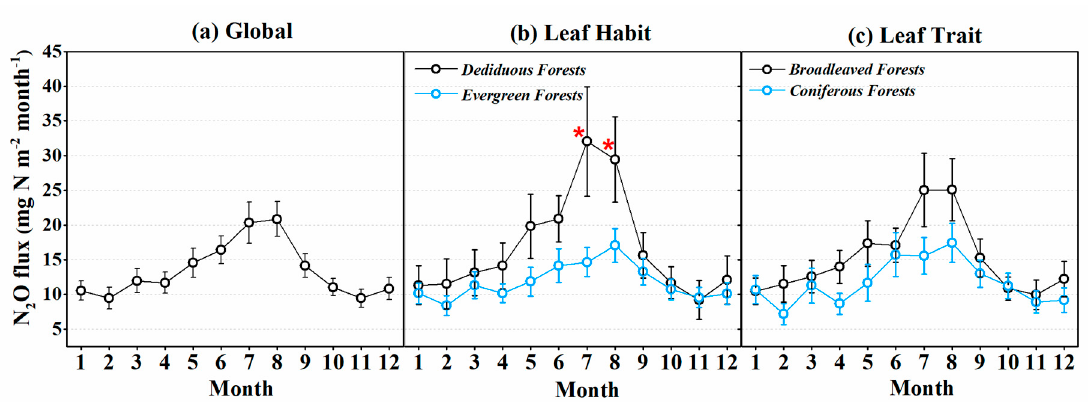
Figure 3. Comparisons of mean monthly nitrous oxide (N 2 O) fluxes of ( a ) global forests, ( b ) leaf habits (LH), and ( c ) leaf traits (LT) for each month. *Represents statistically significant differences ( p < 0.05) among different groups. The error bar represents the standard error (SE).